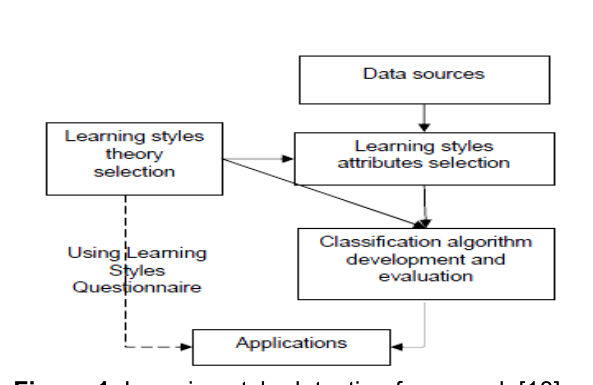
Figure 1 . Learning style detection framework [18] (i) Data Source for Learning Style